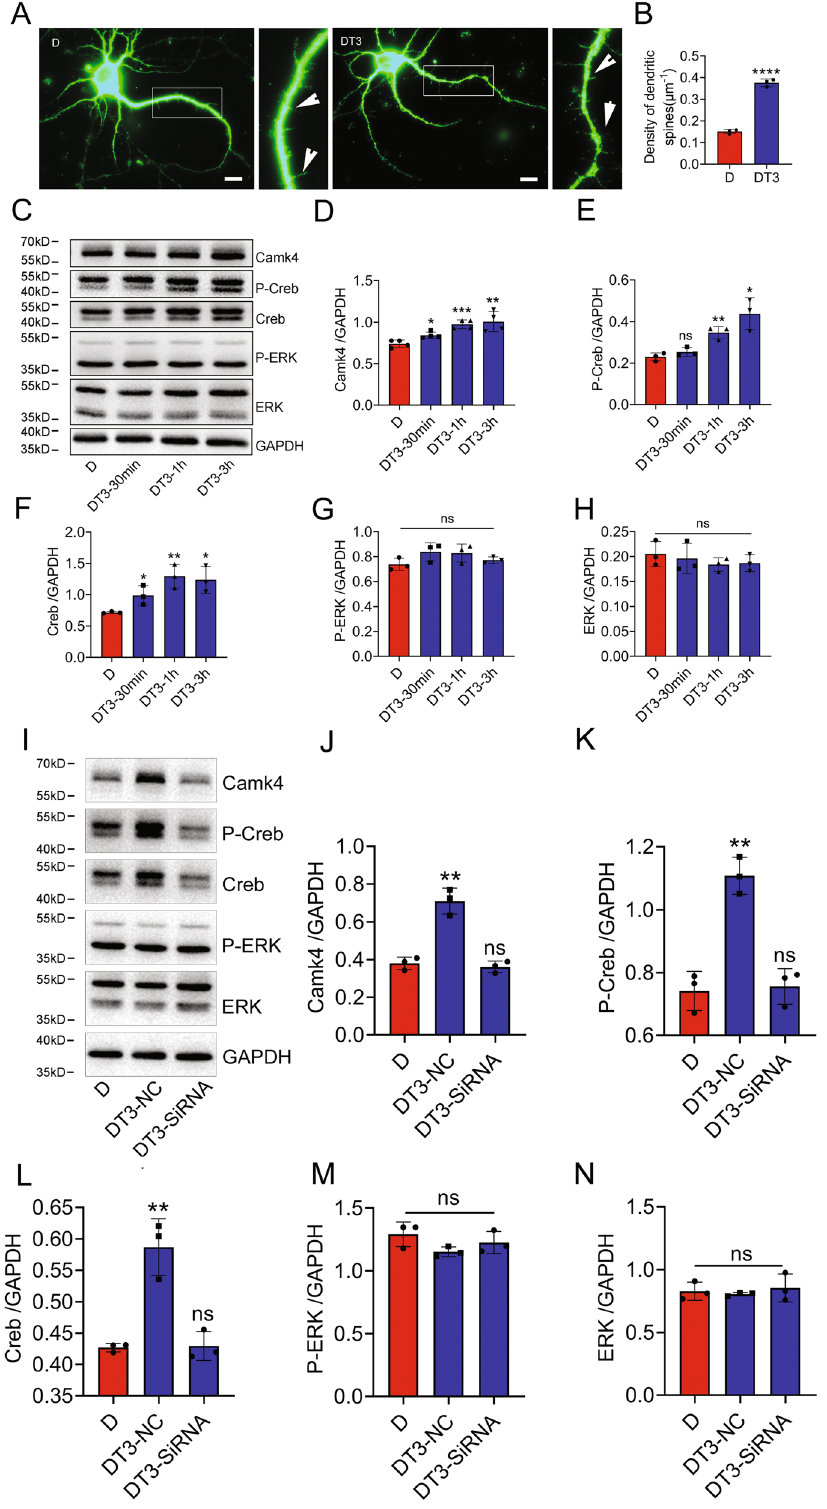
Fig. 7 T3 increased spine density of DGCs from CH fetal rat via activation of CREB. A DGCs from CH E18 fetus were treated with 5 nM T3 for 24 h, followed by culture for another 7 days. Spines were immunostained by MAP2 antibody. The rectangle indicates region magni fi ed. Arrowheads indicate spines. B Statistical analysis of A . Spine density was analyzed in quadruplicates each 15 fi elds. Six pups of each group were used to isolate DGCs. C – H Western blot analysis of CaMKIV, p-CREB/CREB, and pERK/ERK following DGCs treatment with 5 nM T3 for 30 min, 1 h, and 3 h, respectively. D – H are statistical analysis of C . I Western blot analysis of CaMKIV, p-CREB/CREB, and pERK/ERK following DGCs knockdown of CaMKIV for 24 h, and then stimulated with 5 nM T3 for 30 min. J – N Statistical analysis of I . Experiments were performed in triplicates. Error bars represent the standard deviation ( P < 0.05). Scale bars, 10 μ m in A